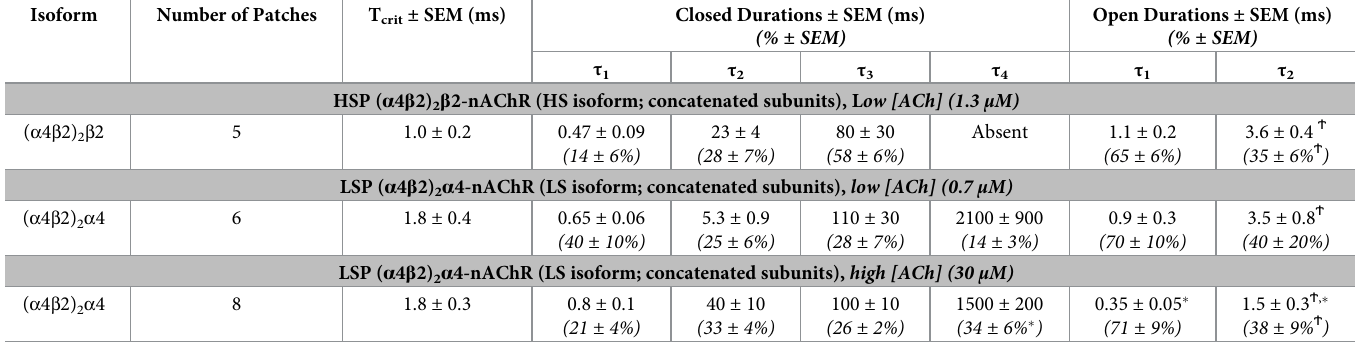
Table 2. Closed and open dwell duration parameters for human HS and LS α 4 β 2-nAChR isoforms expressed using fully-pentameric concatemeric constructs (HSP and LSP, respectively).